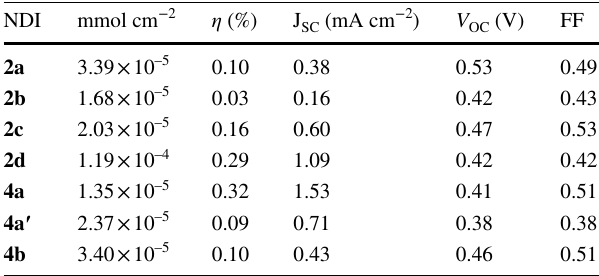
Table 2 Photovoltaic parameter obtained in the DSSC with the NDIs NDI